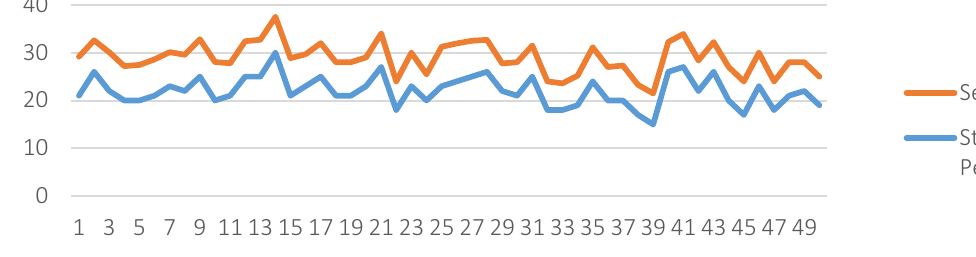
Figure 5. Correlation between self-control and students’ performance